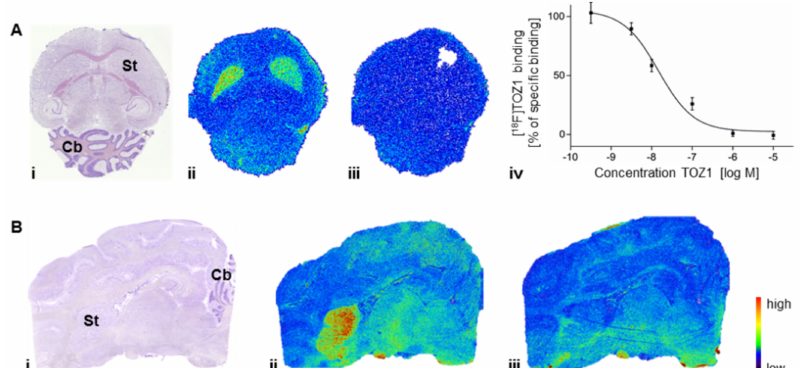
Figure 7. Representative autoradiographic images of ( A ) the transversal plane of mouse and ( B ) the sagittal plane of pig brain slices after incubation with 1.1 nM [ 18 F] TOZ1 : (i) Nissl staining; (ii) total binding; and (iii, iv) nonspecific binding in the presence of 1 µ M ZM241385 ; St = striatum, Cb = cerebellum.